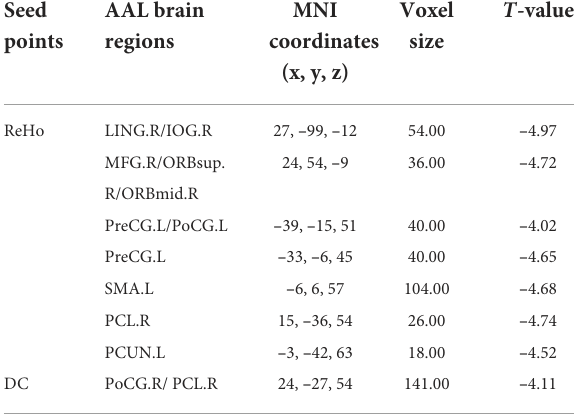
TABLE 3 Abnormal voxel-wise functional connectivity with regions of abnormal ReHo and DC as seed